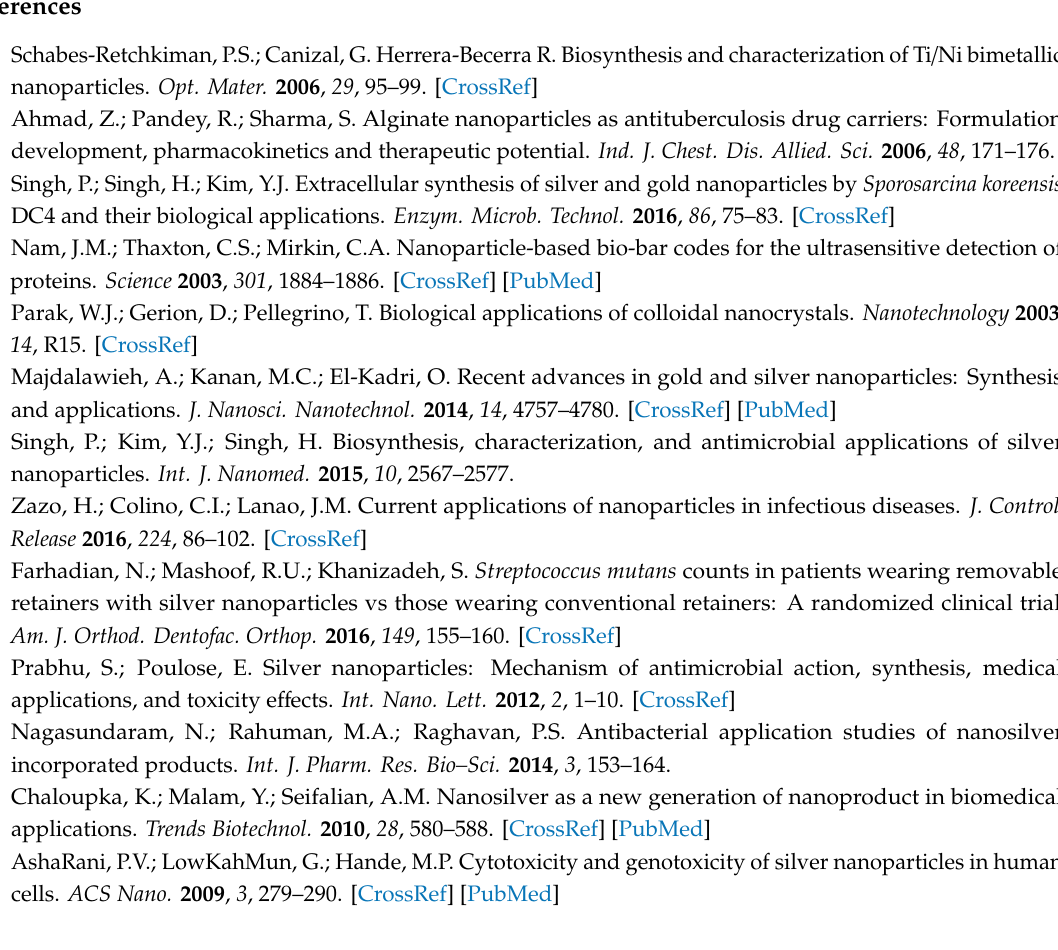
Figure S1: E ff ect of temperature on the biosynthesis of AgNPs using strain Pseudoduganella eburnea MAHUQ-39 was checked on the basis of UV-vis spectral analysis after 24 h of incubation with 1 mM concentration of AgNO 3 , Figure S2: E ff ect of salt concentration (AgNO 3 ) on the biosynthesis of AgNPs using strain Pseudoduganella eburnea MAHUQ-39 was checked on the basis of UV-vis spectral analysis after 24 h of incubation at 30 ◦